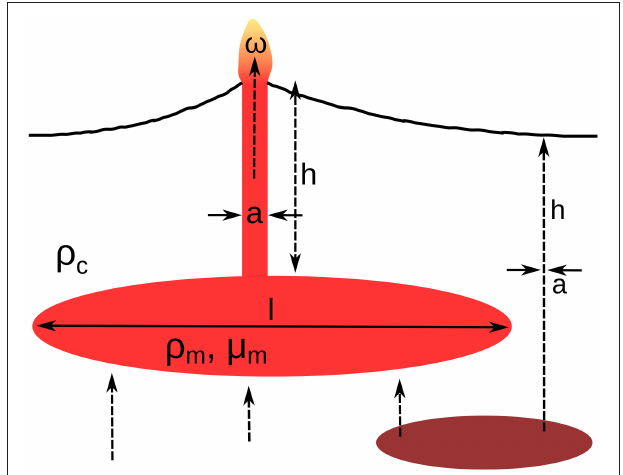
FIGURE 3 | Schematic illustration of a crustal magma reservoir at depth h , with an open fracture allowing magma to ascend with velocity ω from the top of the reservoir. Modified after Kelemen and Aharonov (1998). The fracture of width a forms when the overpressure in the magma chamber exceeds the fracture stress of the crust. The magma reservoir may be fed directly by mantle melts or from deeper, sill-like melt lenses. Under certain conditions, high-density olivine-phyric magmas are enabled to erupt from deep magma chambers directly to the surface. See text for details.